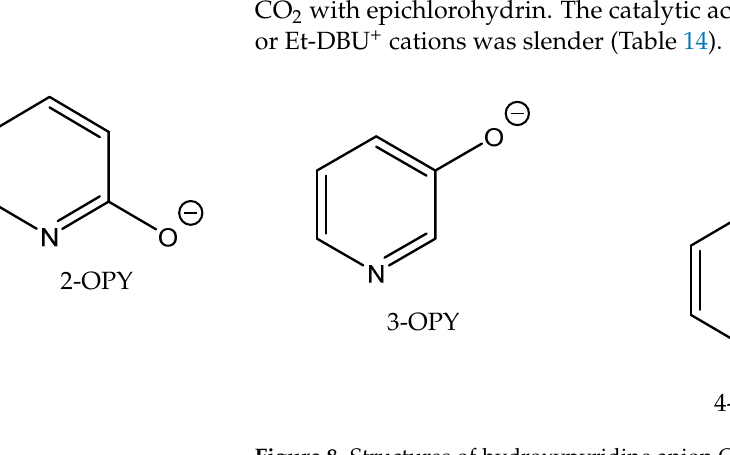
Table 14. Cycloaddition of CO 2 with EPIC catalyzed ILs [69].